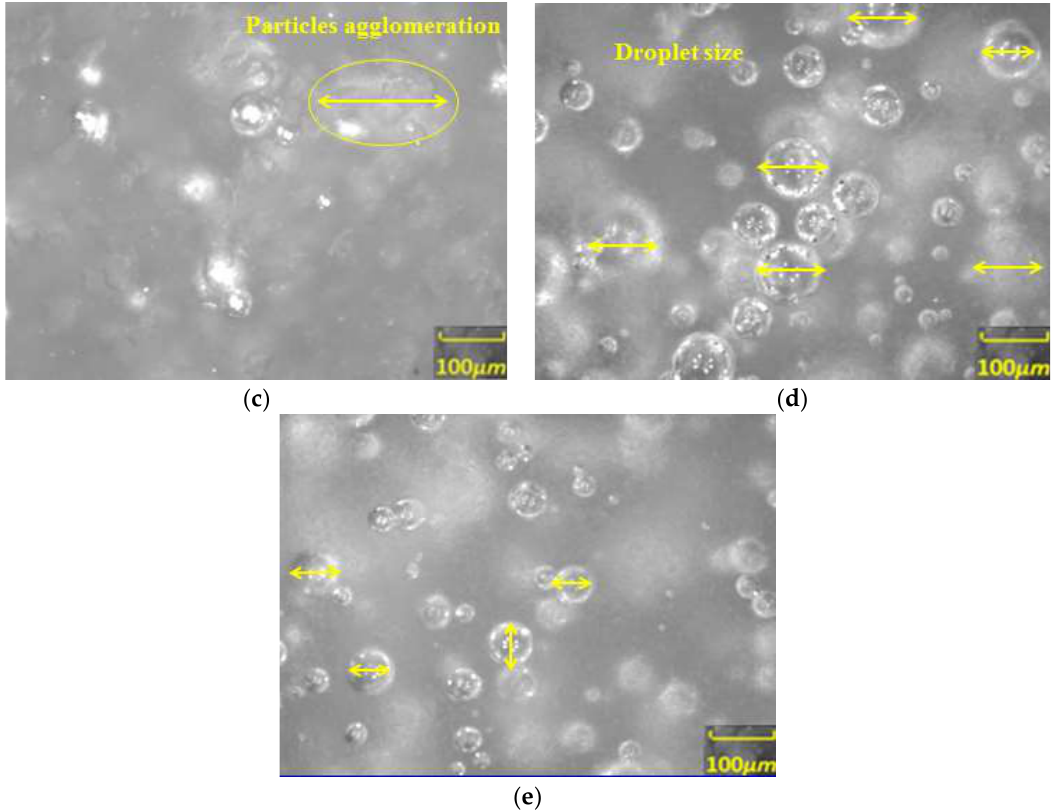
Figure 4. Distribution of particles/droplets in the whole process of hydrate slurry dissociation ( a – e ). ( a ) Before hydrate slurry dissociation. ( b ) Beginning of hydrate slurry dissociation. ( c ) During hydrate slurry dissociation. ( d ) The complete dissociation. ( e ) The longer emulsification time after complete dissociation.